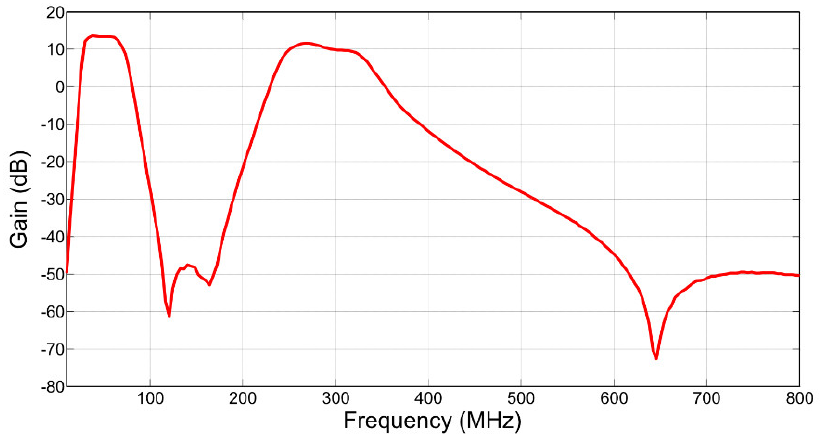
Figure 13. Frequency response of the RF front-end. The output signal from the LNA is then applied to an RF envelope detector, which re-